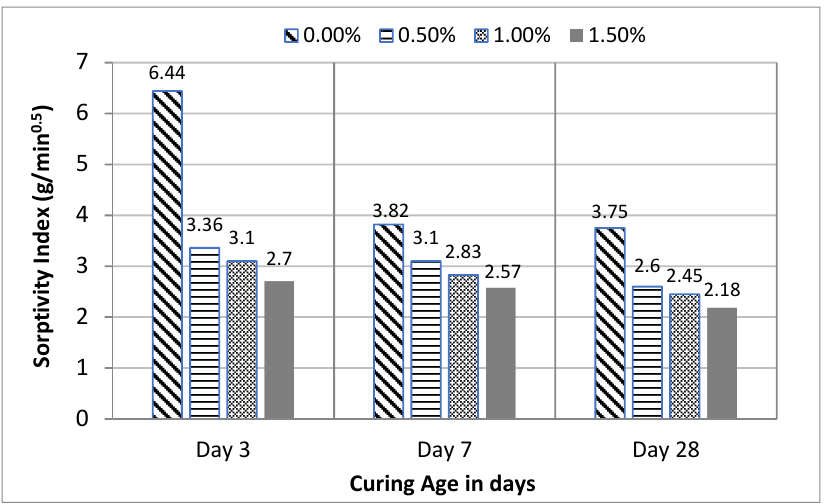
Figure 8. The effect of adding PA fibers on the sorptivity index of concrete mixes at 3, 7, and 28 days of curing.